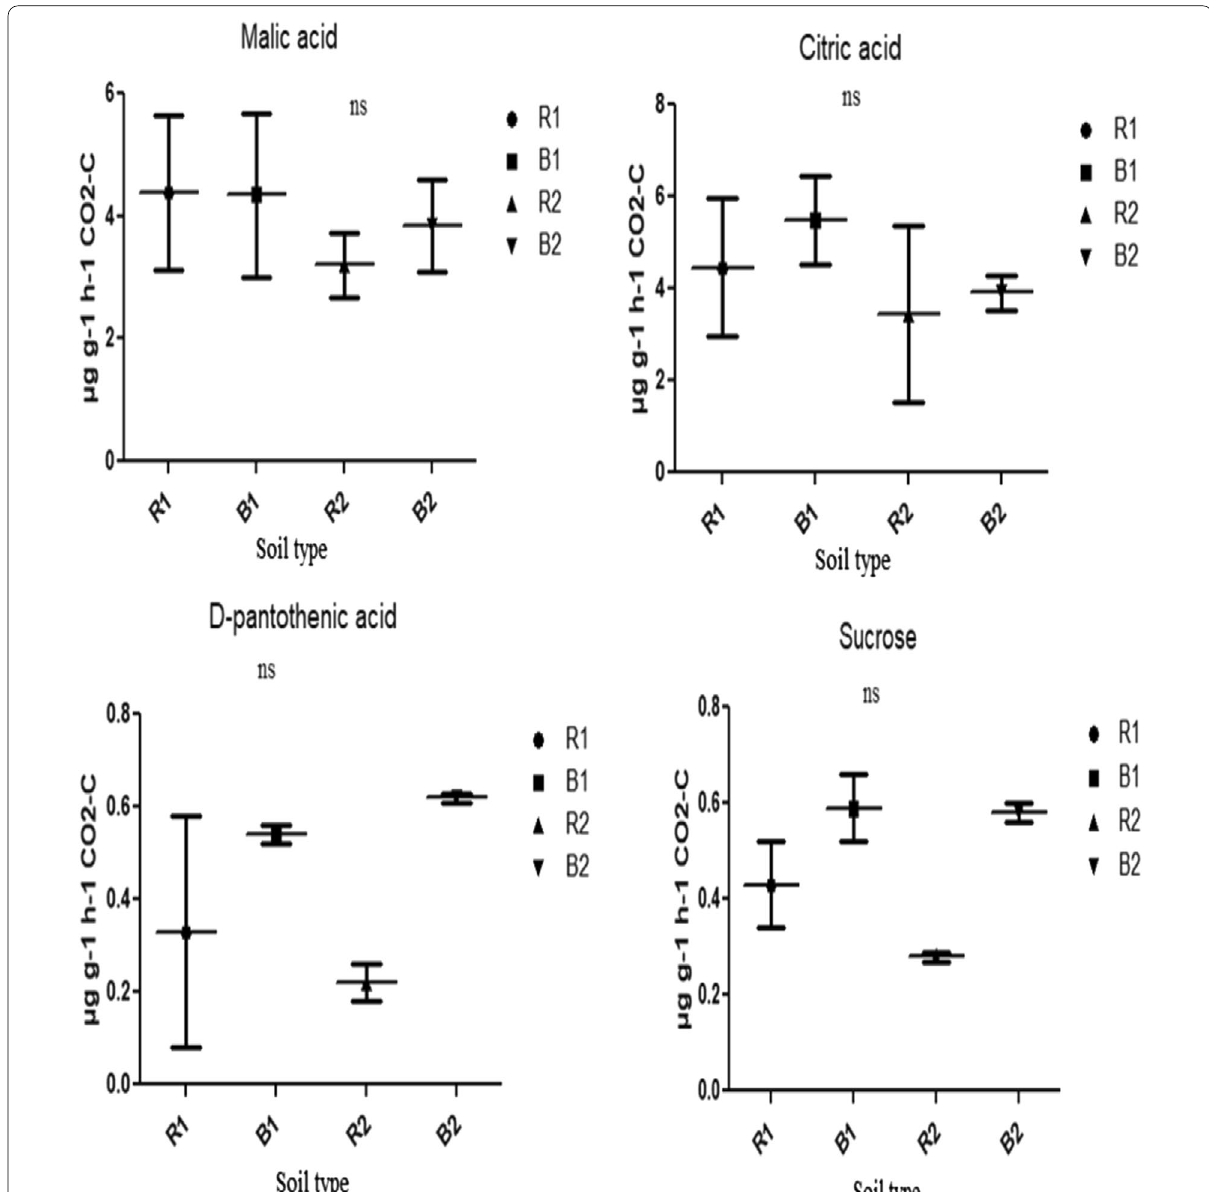
Fig. 7 Effects of soil type on soil functional properties as measured for malic acid, citric acid, d -pantothenic acid and sucrose using MicroResp assay. Number of replicates (n) 2. Number of replicates (n) 2. Data represent mean SE, ns not statistically significant; R1 Ditsobottla rhizosphere soil; = = ± B1 Ditsobottla bulk soil; R2 Kraaipan rhizosphere soil; B2 Kraaipan bulk